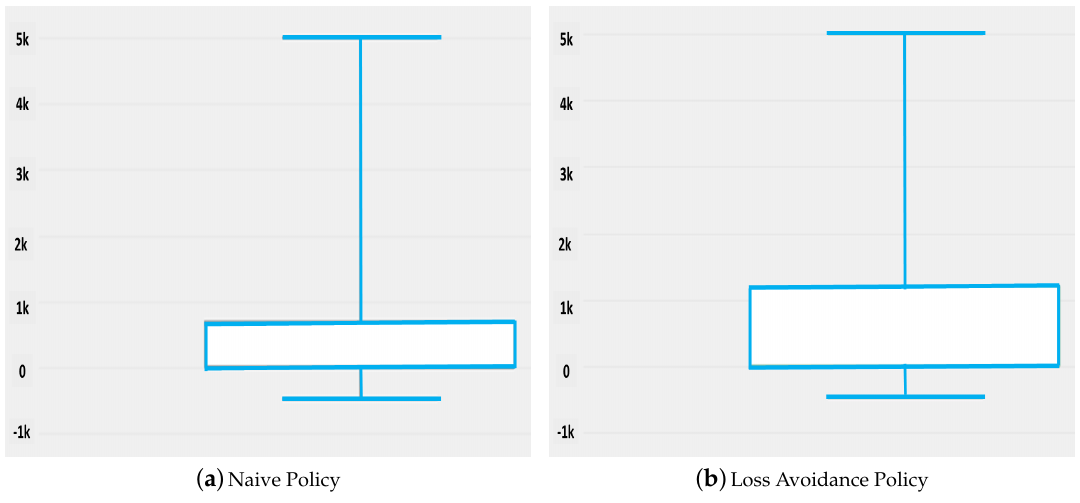
Figure 8. Obtained results for feed-in to the power grid.